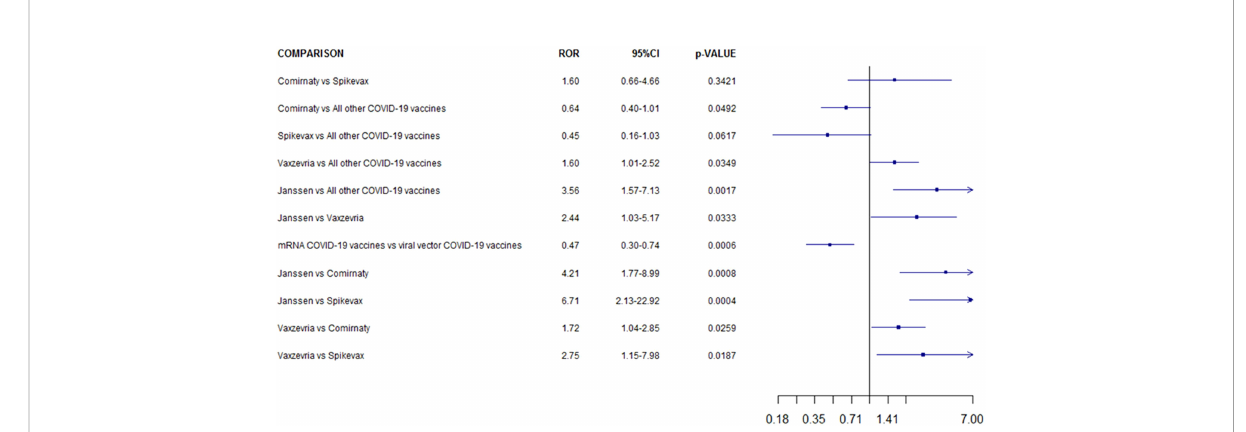
FIGURE 3 Reporting odds ratio of COVID-19 Vaccines ICSRs with capillary leak syndrome collected in the EudraVigilance spontaneous reporting system from January 1 st 2021 to 14 th January 2022